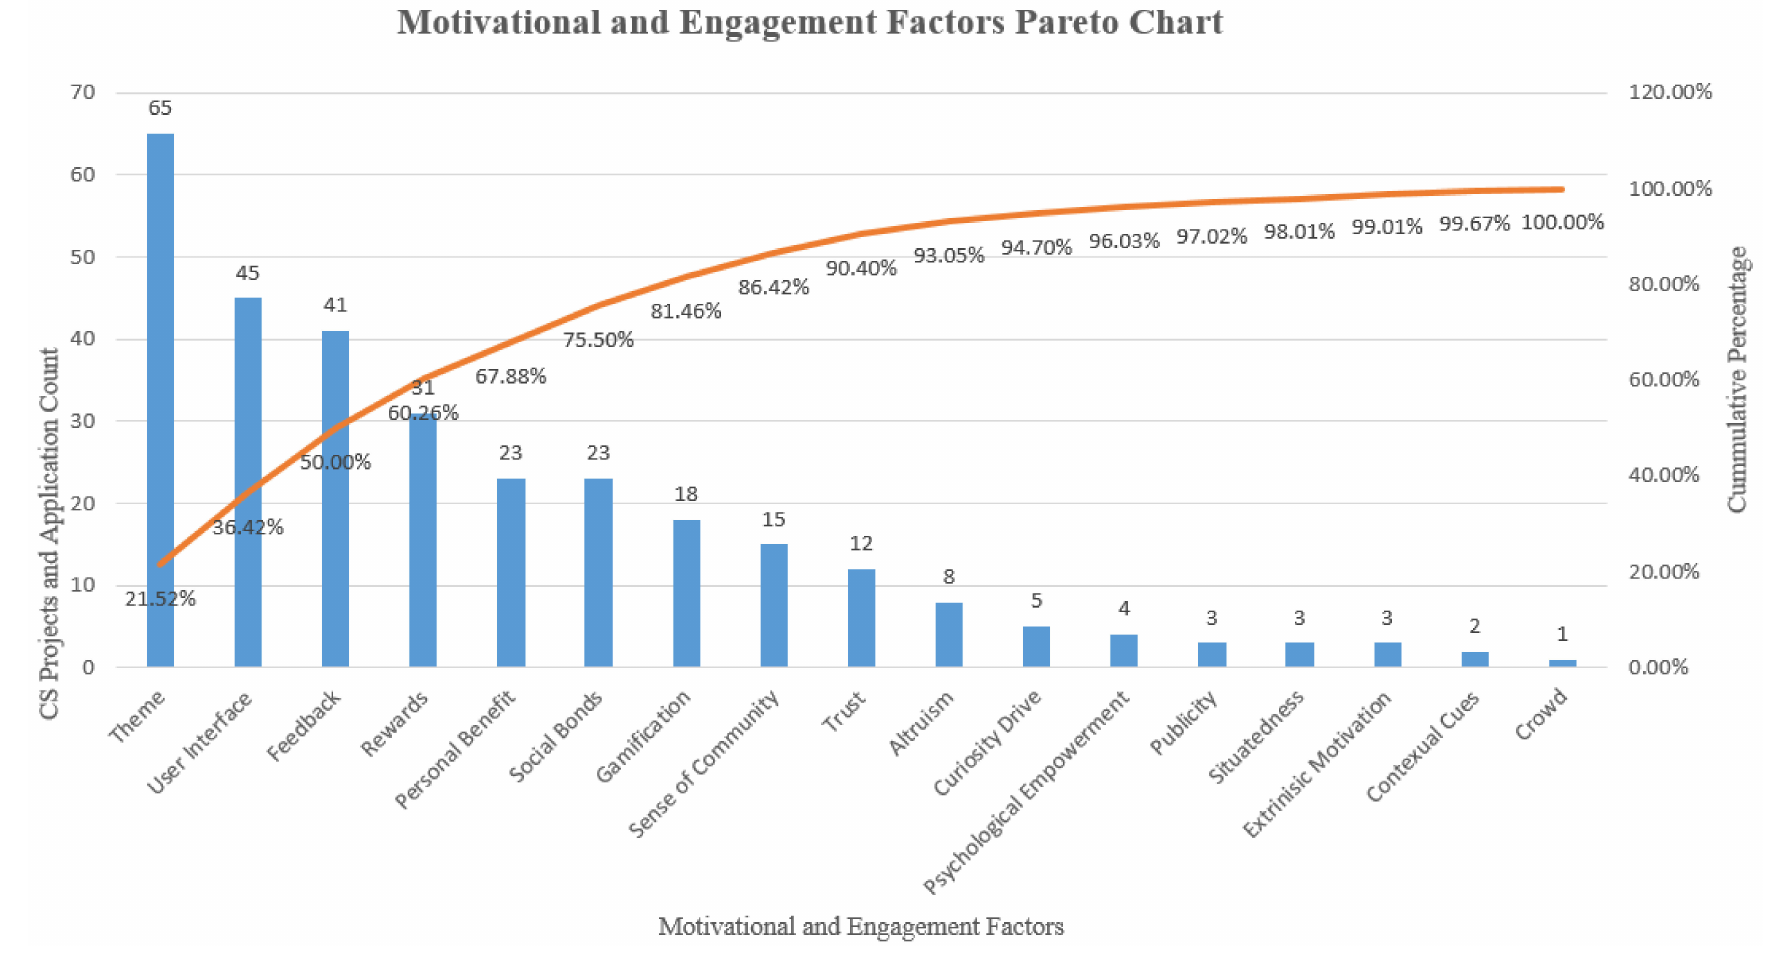
Figure 3. Motivational and Engagement Factors Pareto